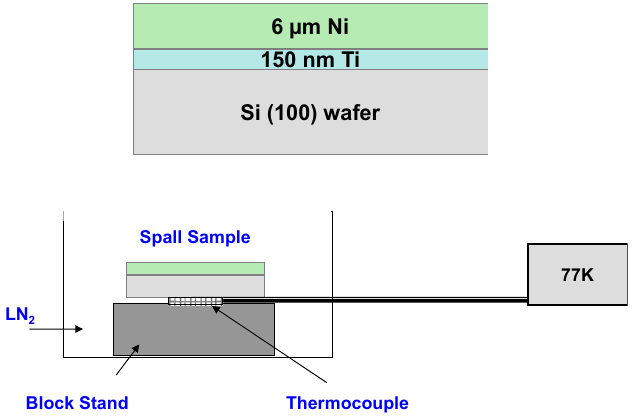
Figure 6. Liquid nitrogen temperature Si(100) spalling can be carried out as follows: pieces of 100 semiconductor materials (nominally 1.5, 3 inch pieces) are HF-dipped until hydrophobic (optional), N 2 -dried, immediately placed into a sputter system for metal layer deposition, and then, Kapton tape is placed onto the Ni surface and cooled using liquid nitrogen.